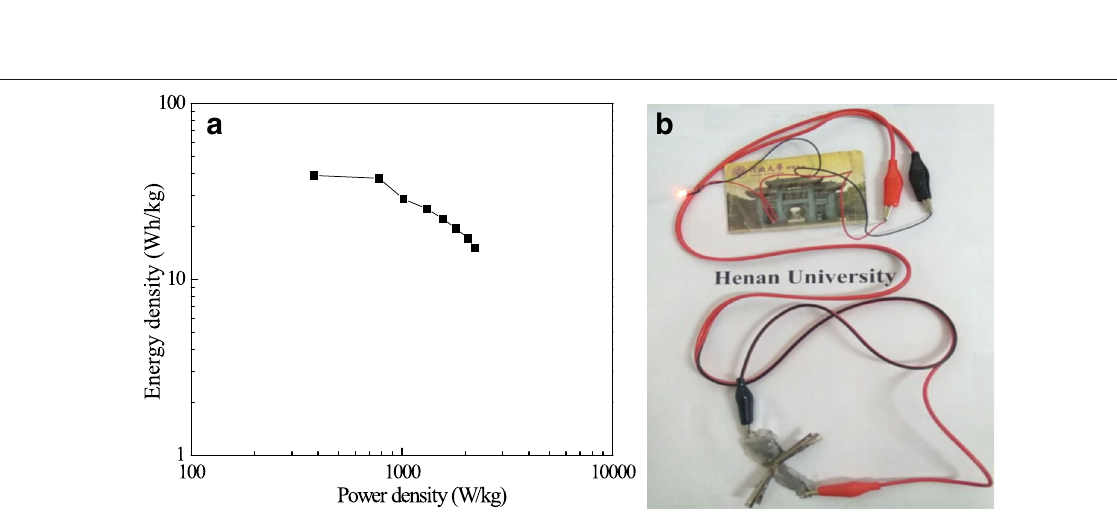
Fig. 7 CVs at different voltage windows ( a ), GCD at different current densities ( b ), EIS ( c ), and the stability after 1000 cycles CVs (black line), and specific capacitance at different current densities (red line) ( d ) for the quasi-solid-state MM//PM ASC